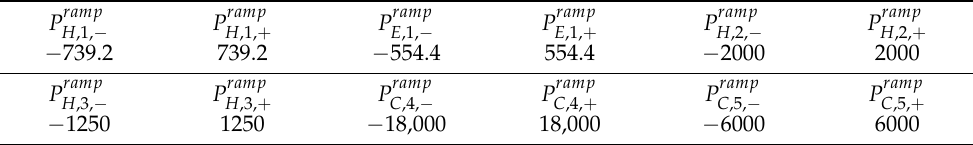
Table 4. Ramp rate of EH devices in the test system